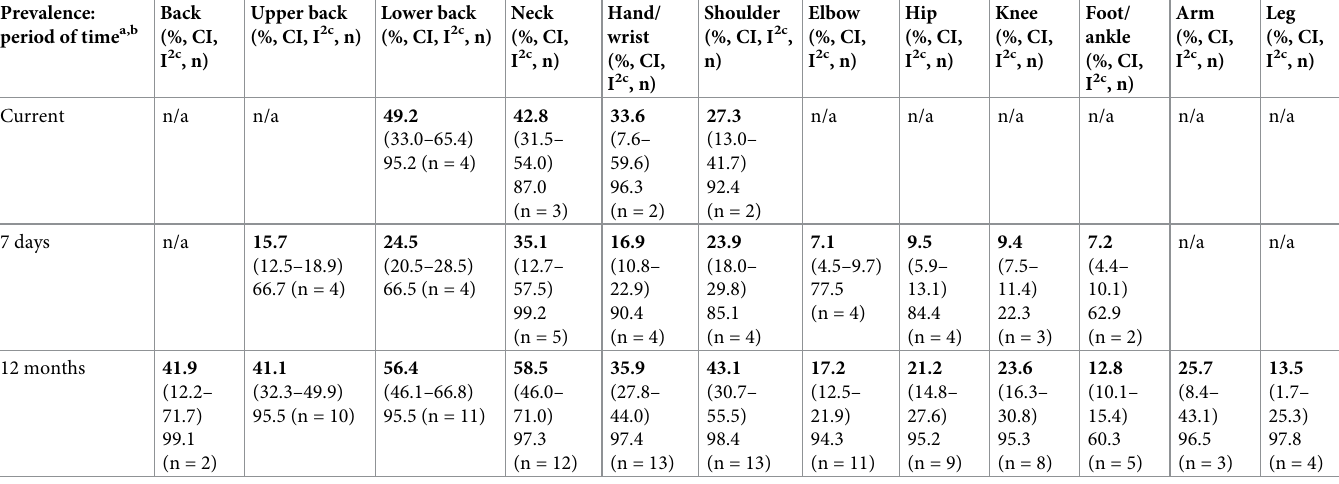
Table 4. Pooled prevalence rates of MSDs/MSP among dental professionals stratified by body region and period of time. Prevalence: Back period of time a,b (%,